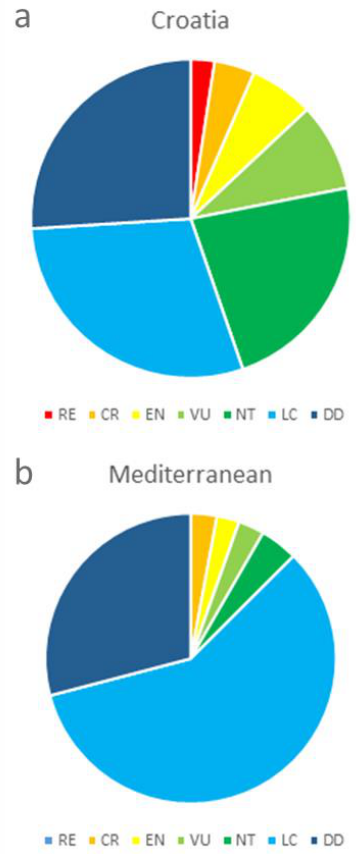
Figure 7. Red List of native marine fish species (including both bony and cartilaginous fishes) known to occur in the Croatian part of the Adriatic Sea ( a ) [68], (the assessment was performed for only a quarter of all Adriatic fish species) and in the Mediterranean Sea ( b ) [72]. Legend: RE — regionally extinct, CR — critically endangered, EN — endangered, VU — vulnerable, NT — nearly threatened, LC — lower concern, and DD — data deficient.